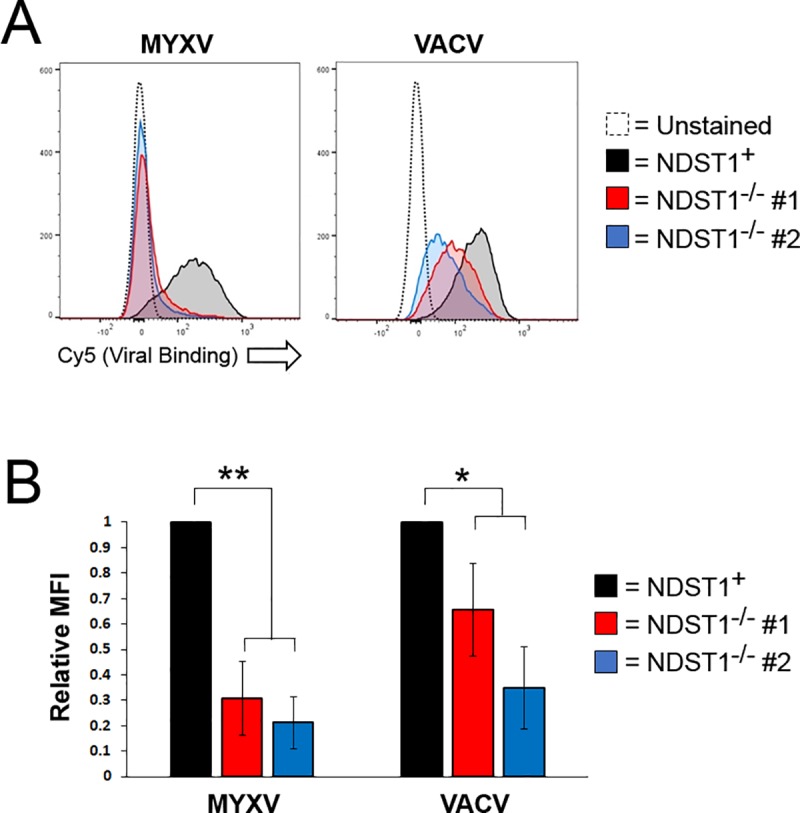
Loss of sulfation reduces binding of both MYXV and VACV virions.(A) Histograms depicting binding of fluorescent viral virions to the cell surface. Cells were incubated on ice with Cy-5 labeled MYXV or VACV at 4 particles per cell and washed with cold PBS to remove residual virus. Cells were resuspended in 2% PFA and levels of Cy-5-labeled virus bound to the cell membrane was measured via flow cytometry. Data shown is representative of two independent experiments each done in triplicate. (B) Relative MFI values of Cy-5 (viral binding). MFI values were normalized to NDST+ to determine the relative change in NDST-/- cell lines. Statistical MFI calculations are a summation of the two independent experiments each conducted in triplicate. Statistical significance was determined using non-parametric Mann-Whitney test. ** = p<0.01, * = p<0.05.